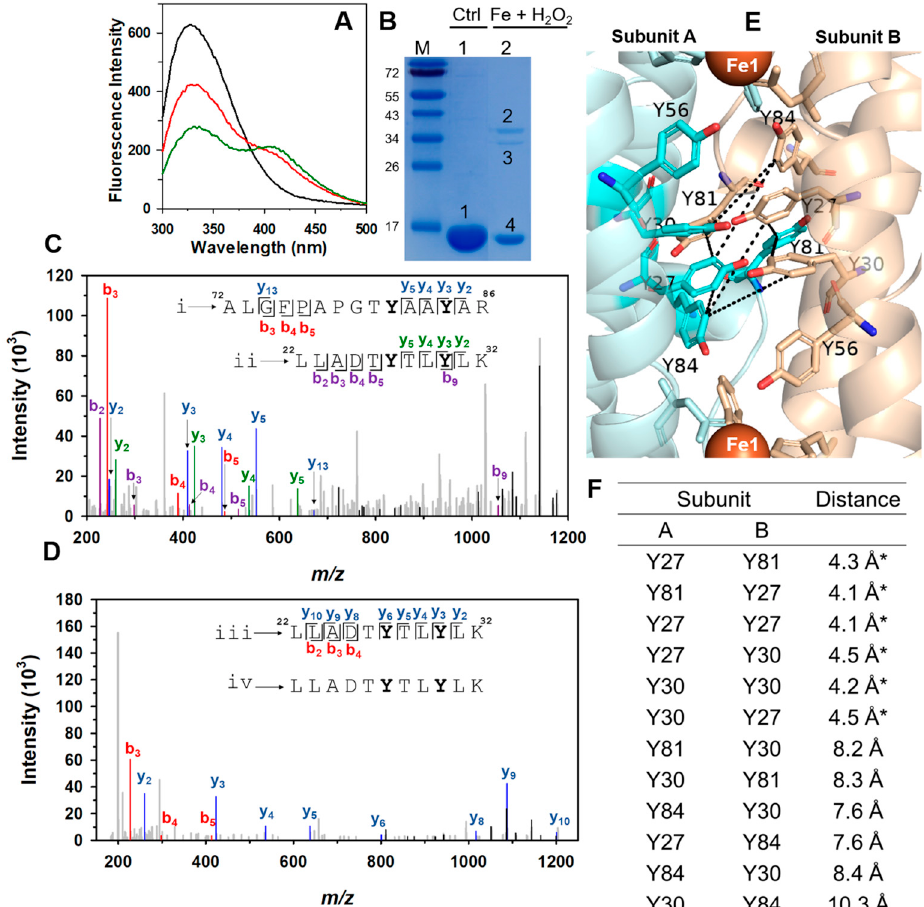
Figure 7. Anaerobic oxidation of Fe 2+ with H 2 O 2 leads to Y-Y crosslinked Pa Dps: ( A ) Fluorescence spectra (280 nm excitation) of 12-mer Pa Dps (1 μ M) in 75 mM Bis-Tris (pH 6.5) containing 1 mM Mg 2+ before (black) and after the addition of two aliquots, each delivering 24 Fe 2+ /12-mer and 1 equivalent of H 2 O 2 (red and green, respectively). ( B ) SDS PAGE gel loaded with Pa Dps (ctrl) and Pa Dps titrated with a total of 48 Fe 2+ /12-mer and one equivalent of H 2 O 2 . M = molecular weight marker. ( C , D ) Annotated ESI-MS/MS spectra of Y-Y crosslinked peptides i–ii and iii–iv, respectively. Band 2 in the gel contained crosslinked peptide i–ii, and band 3 contained peptides i–ii and iii–iv. ( E ) Residues implicated in possible Y-Y crosslinks. ( F ) Distances measured from an o-phenol carbon in one Tyr to the closest o-phenol carbon in the accompanying Tyr. The * denotes probable crosslinks.